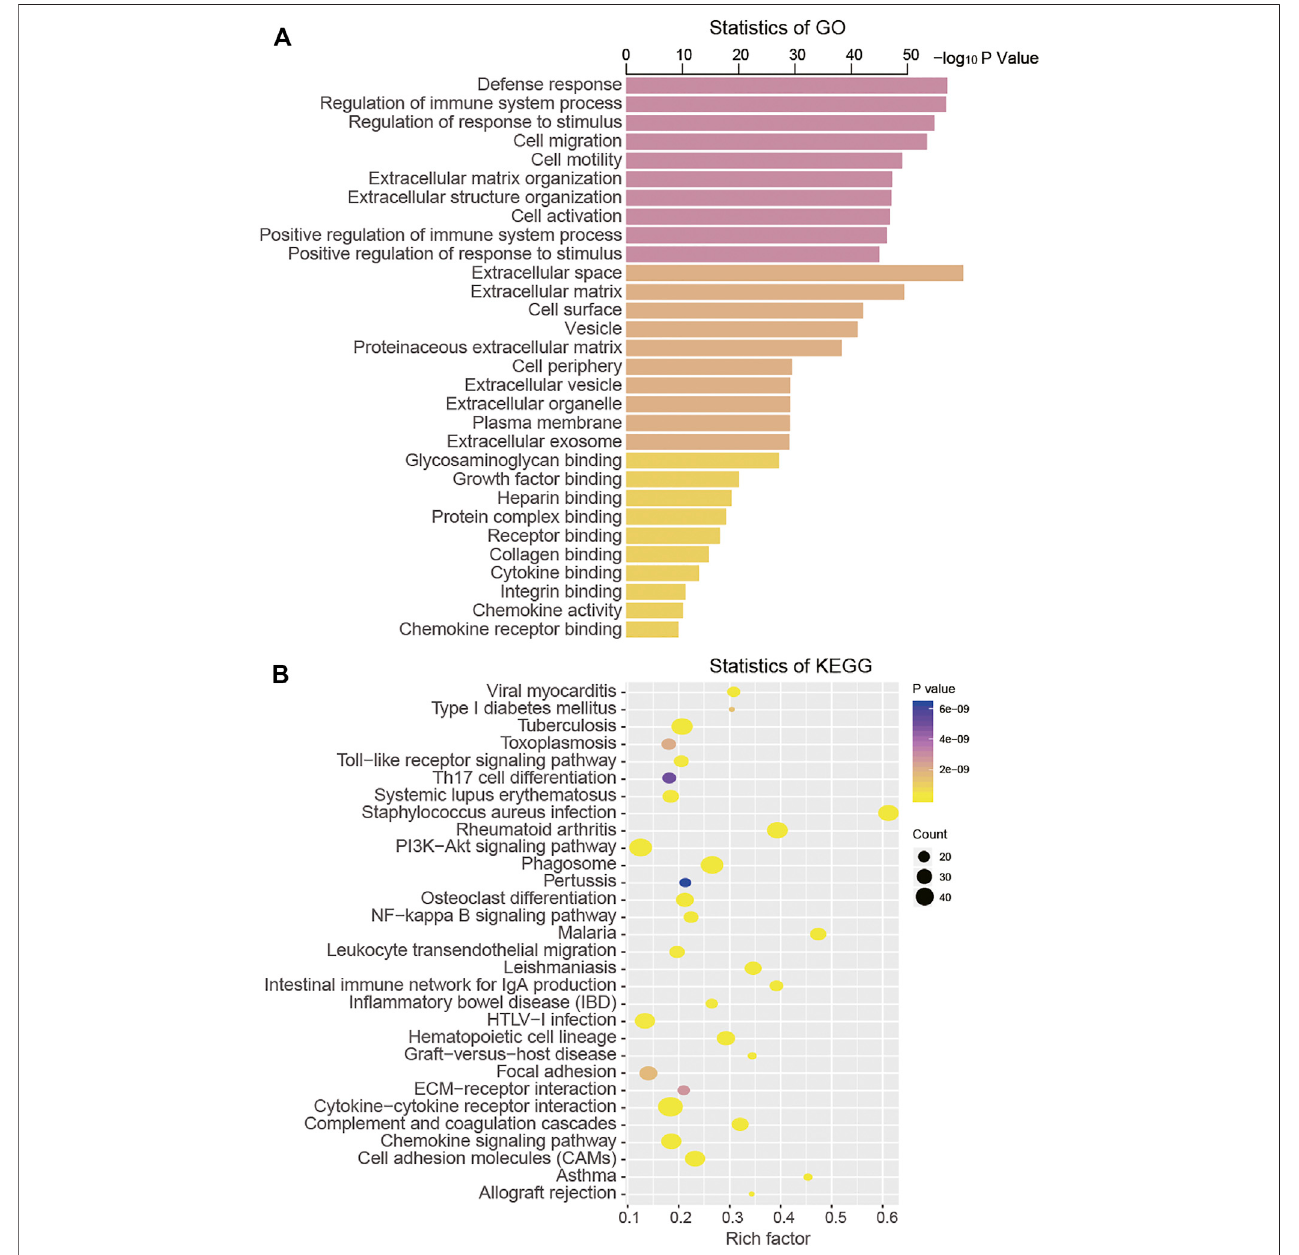
FIGURE 4 | Functional analysis of intersection DEGs by GO (A) and KEGG (B)